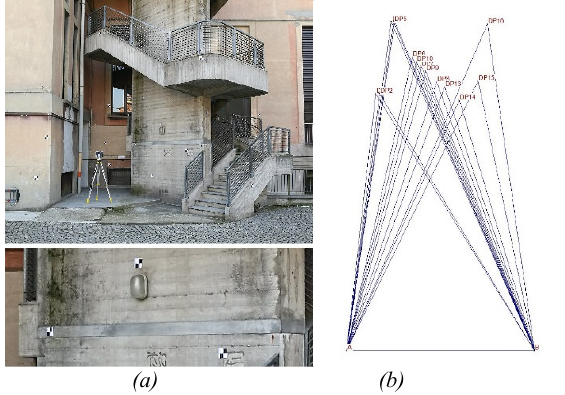
Figure 2. The calibration field (a); top view of the compensated topographic network